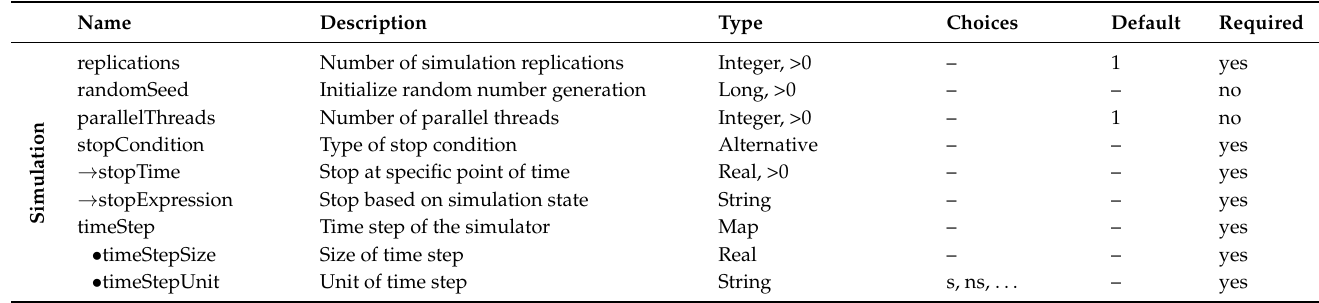
Table 2. Modified meta model component for virtual prototyping of heterogeneous systems. In contrast to simulations that are only based on discrete events, here also, a time step has to be configured for the numerical integration. The rows describe the different input properties of the meta model. Sub-properties are denoted by “ • ”. Alternative meta model parts are indicated by “ →